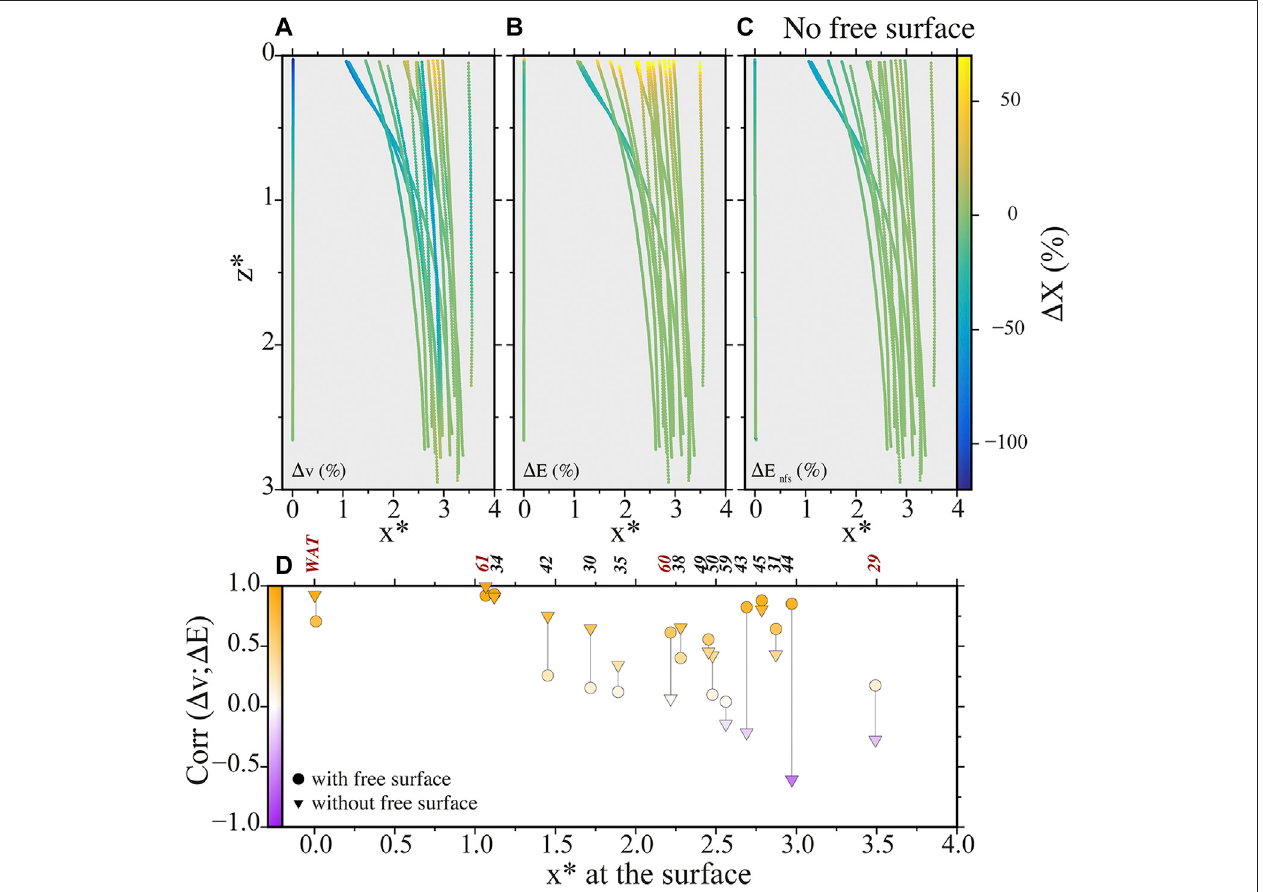
FIGURE 6 | Comparison between the strain and potential energy release alongthe trajectory and the velocity evolution for all experimental trajectories. (A) Velocity variationsas function ofdepth. Thevelocityvariation isrelative to thevelocity ofreference ( V ref ) as in Figure 3 . (B) Strainand potentialenergy release variations alongthe trajectoryderivedfromtheBEmodel.Variationsarerelativetothemeanvaluede fi nedover1 cmatbottomofthetrajectory. (C) Similarto (B) whenremovingtheeffectof free surface. (D) Pearson correlation coef fi cient between the velocity and the energy release for all trajectories. Trajectories are labelled (in red for experiments displayed in Figure 5 ) and ranked as a function of the lateral position at which the crack reaches the surface. Circles and triangles are for coef fi cients considering the energyrelease obtained,respectively, withand without any free surfaceeffect. Vertical and lateral dimensionsare normalized by thehalf-length ofthe load applied at the